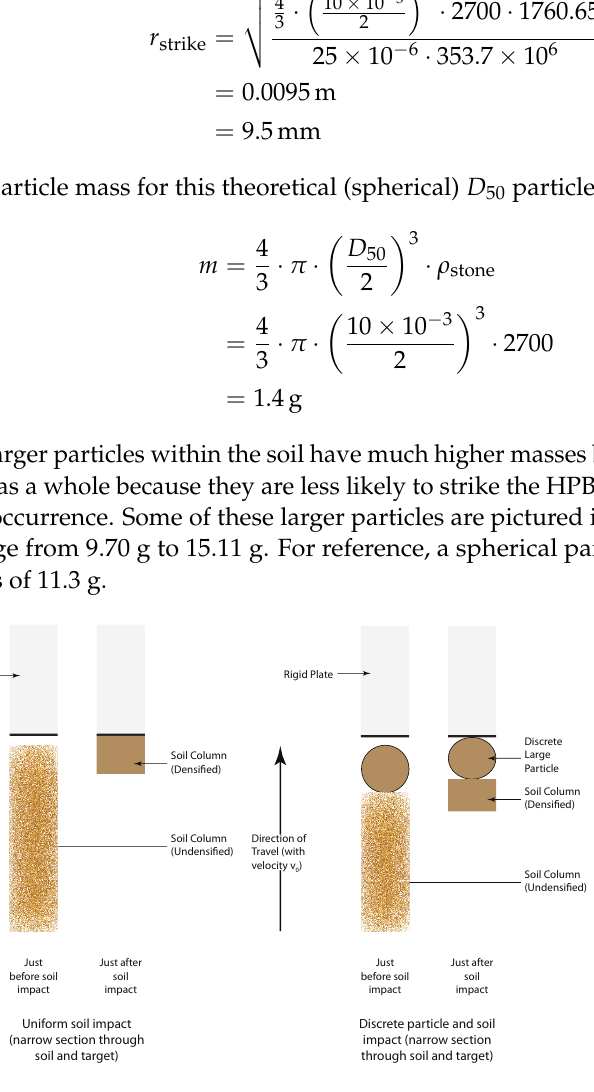
Figure 12. Densification of a soil column, without and with a discrete particle strike.